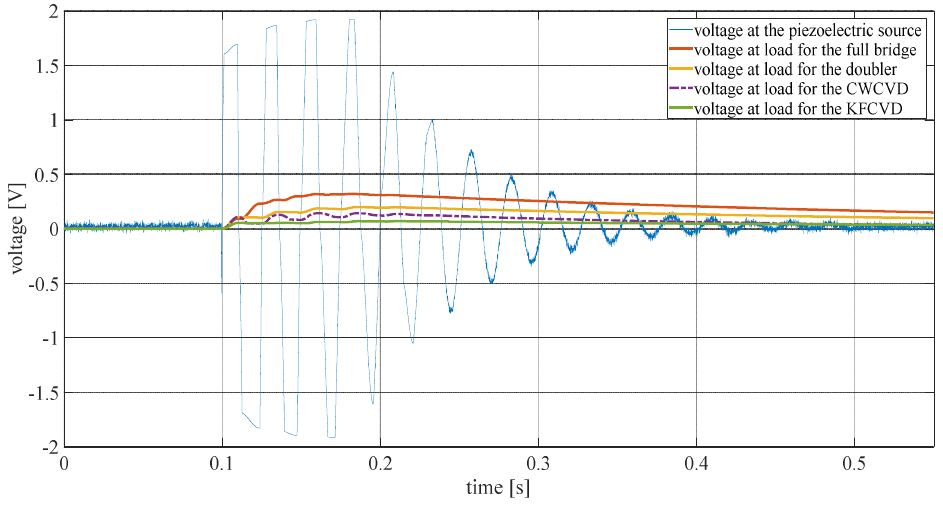
Figure 16. Voltages on the load in different cases for a single raindrop hitting the piezoelectric harvester. Blue color indicates the performance without considering any rectifying circuit. Orange is the performance of the full bridge circuit; yellow is that of the Greinacher doubler, pink is that of the CWCVD and finally green is that of the KFCVD.